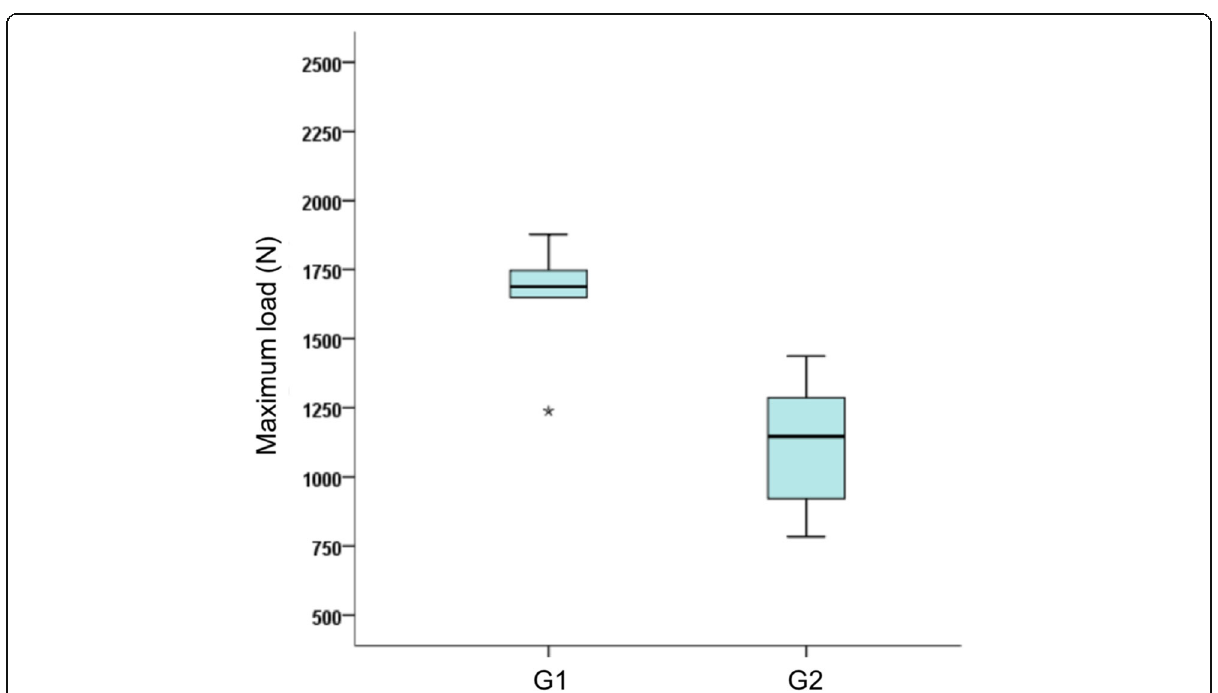
Fig. 6 Maximum load (in newtons) by group. The central bar corresponds to the median (2nd quartile) and the bottom and top bars in the box correspond to the 1st (Q1) and 3rd quartiles (Q3), respectively. The top and bottom vertical bars express dispersion of the distribution and the asterisk (*) corresponds to outliers beyond the expected limits